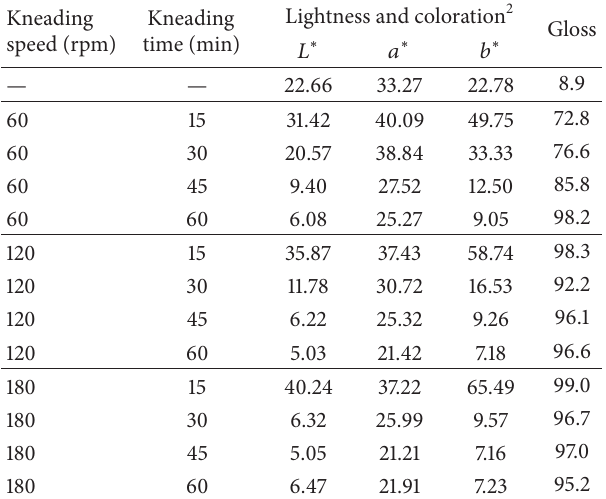
Table 6: Lightness, gloss, and coloration of kneaded lacquer films 1 .